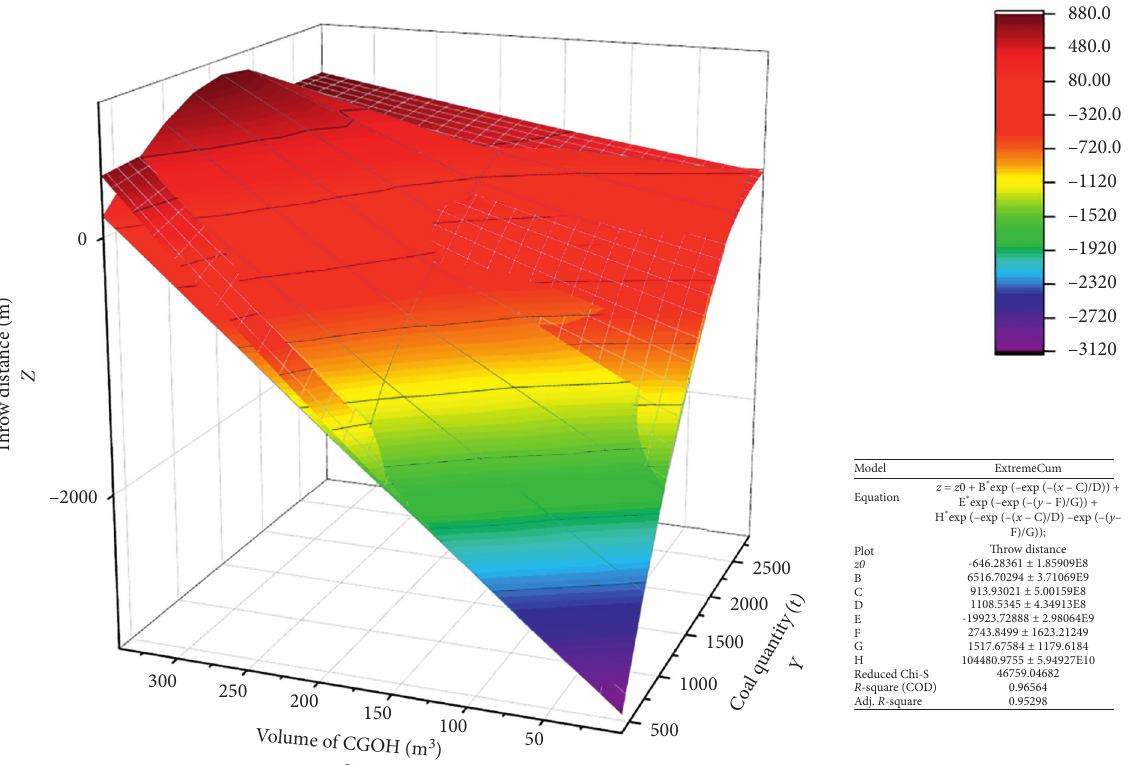
Figure 21: 3D colormap surface of CGOH parameters and its nonlinear surface fit (Extreme Cum).